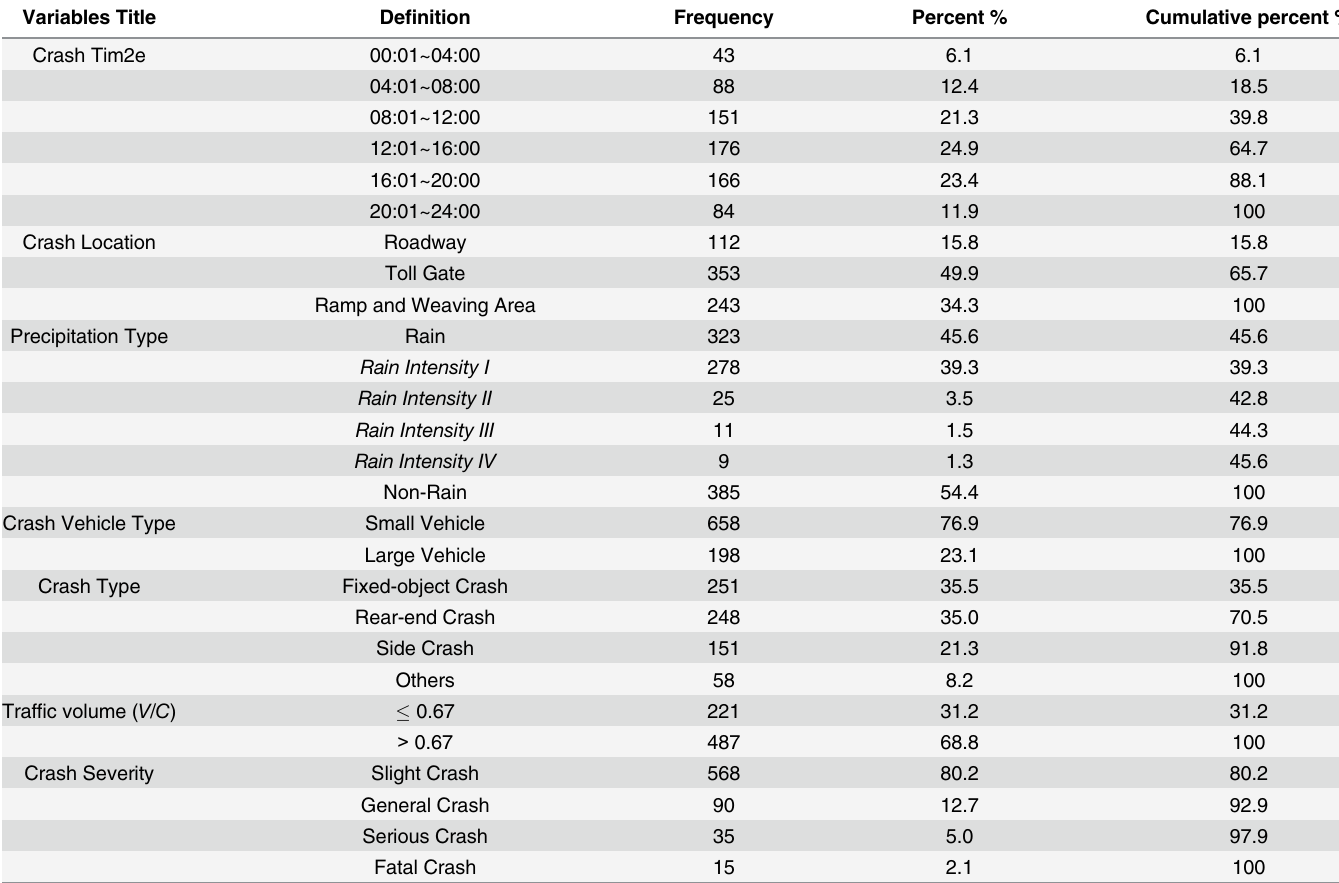
Table 5. Descriptions of crashes from the segment of National Freeway